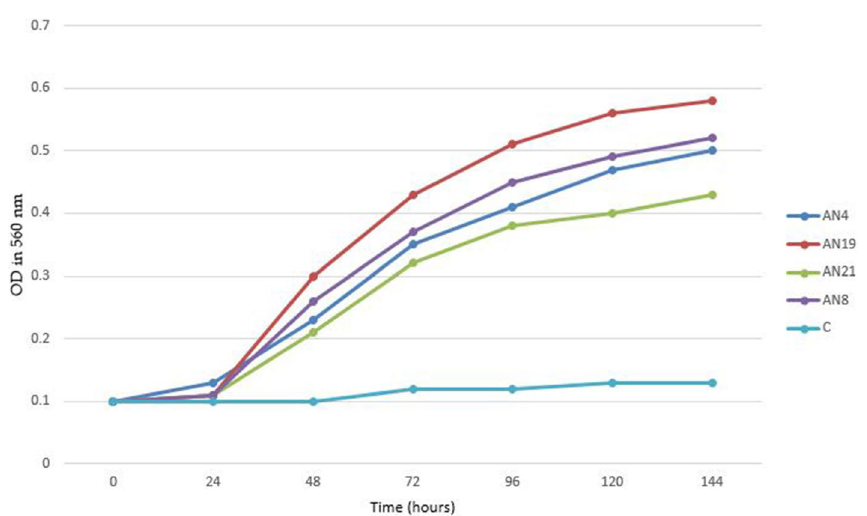
Figure 5. Growth curves of Iranian Nocardia isolates over a 24 h. Incubation period at 30 °C in the presence of phenol. C control